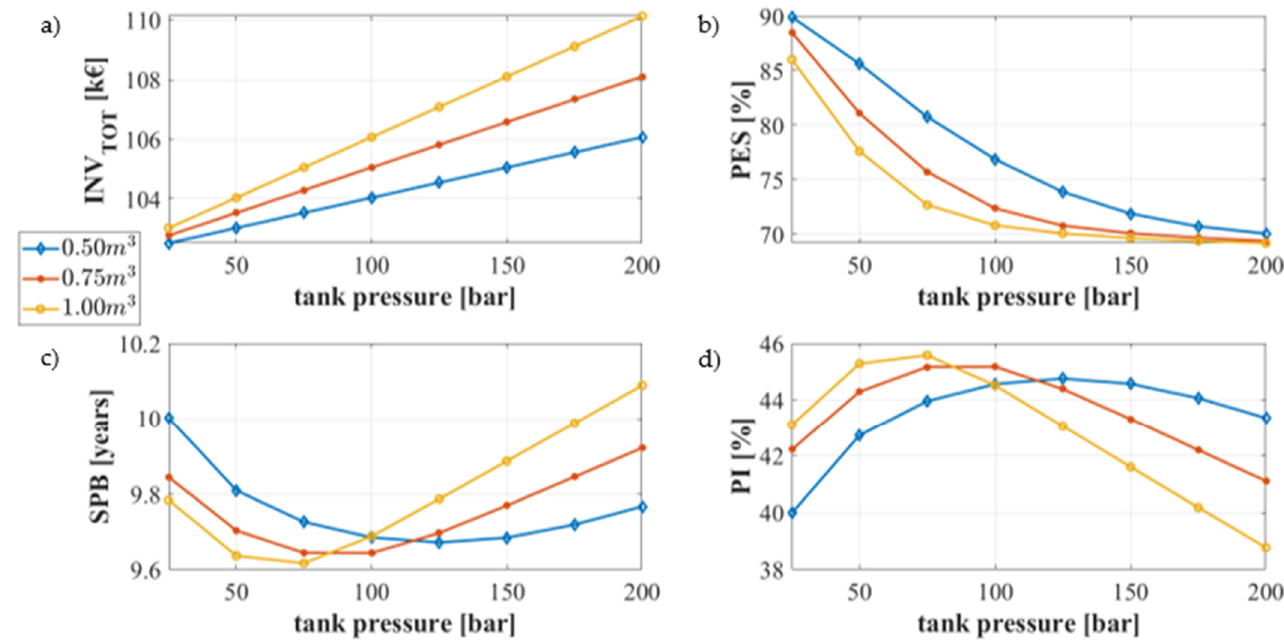
Figure 10. Parametric analysis of the hydrogen storage system: ( a ) total capital costs, ( b ) primary energy saving, ( c ) simple payback, ( d ) profit index, as a function of the maximum storage pressure.